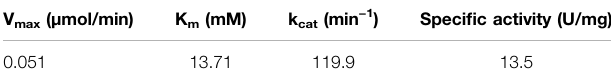
TABLE 2 | Free papain kinetic parameters calculated using BAEE as the substrate.